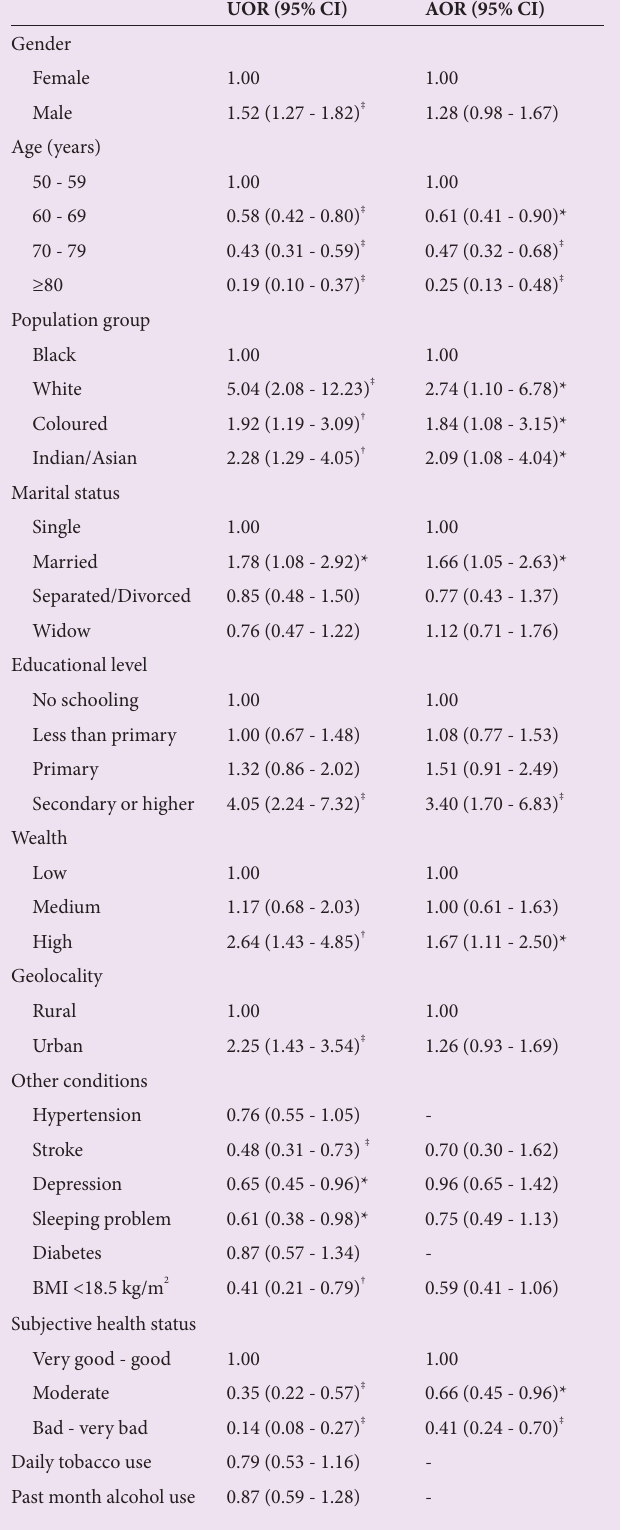
Table 2. Multivariate logistic regression with cognitive functioning in older South Africans